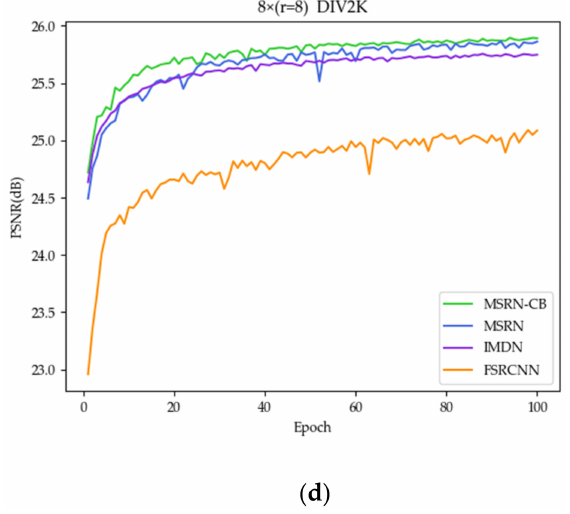
Figure 7. Comparison of the peak signal-to-noise ratios (PSNRs) of the multi-scale residual network (MSRN, blue line), MSRN-CB (green line), information multi-distillation network (IMDN, purple line), and fast super-resolution convolutional neural network (FSRCNN, orange line) with training on the diverse 2K (DIV2K) dataset and up-sampling factors r values of ( a ) 2, ( b ) 3, ( c ) 4, and ( d ) 8. Table 1. Comparison of MSRN-CB with MSRN, IMDN, and FSRCNN. The numbers in red and blue represent optimal and suboptimal values,